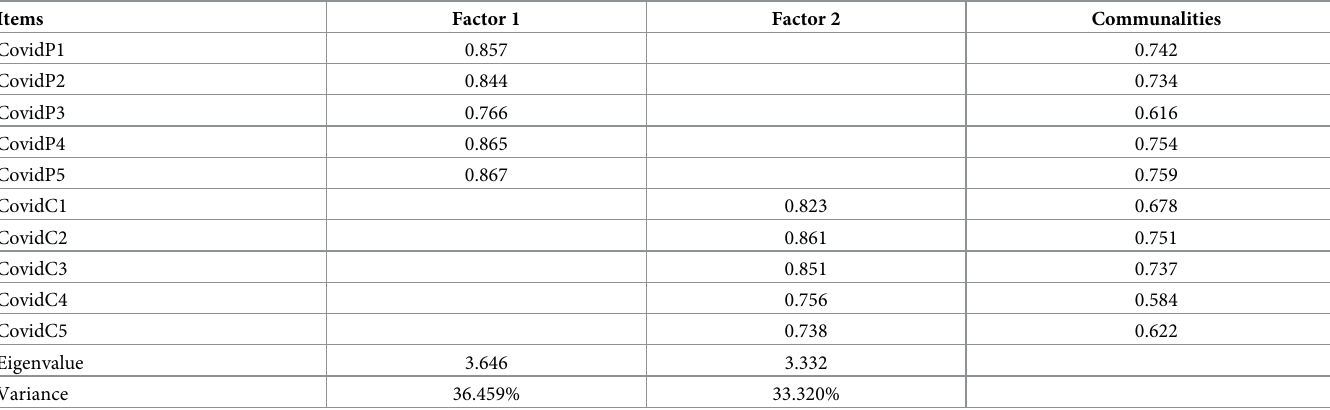
Table 2. Results of Exploratory Factor Analysis (EFA) (sample n =